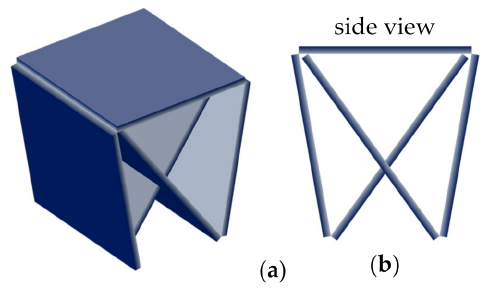
Figure 5. 3rd design: ( a ) perspective view; ( b ) front view.